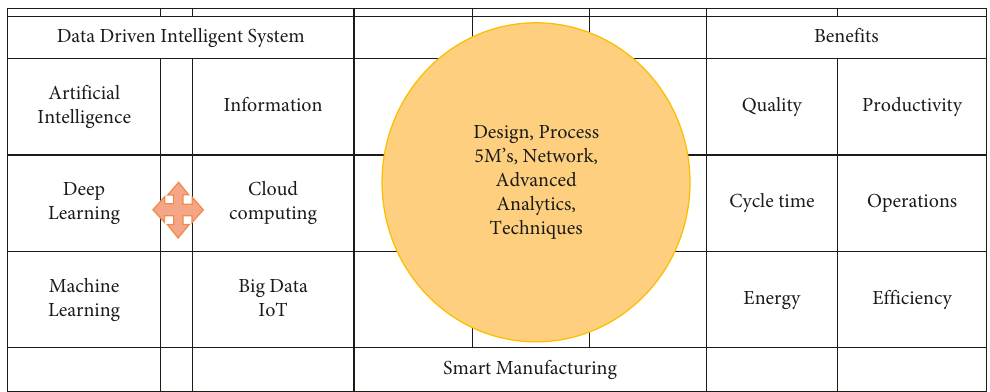
Figure 2: Smart manufacturing: elements and its